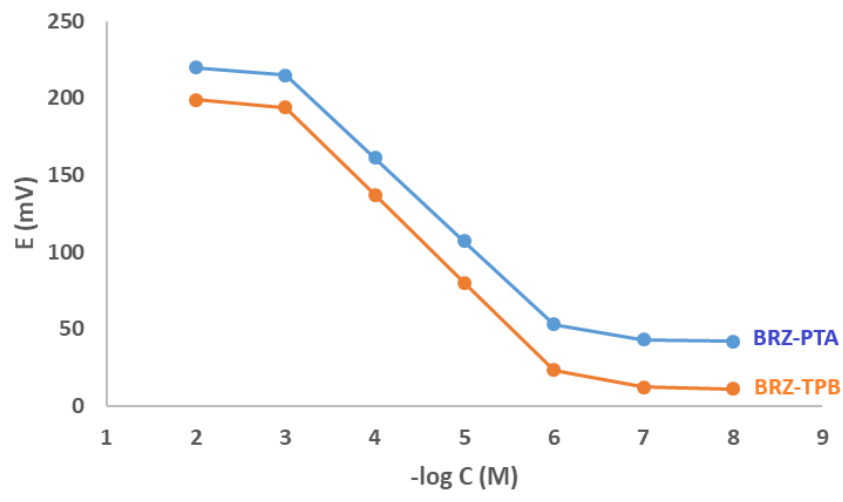
Figure 2. Profile of the potential (in mV) versus –log concentration (in M) for bromazepam-phosphotungstate (BRZ-PTA) and bromazepam-tetraphenyl borate (BRZ-TPB membrane sensors at pH 4.